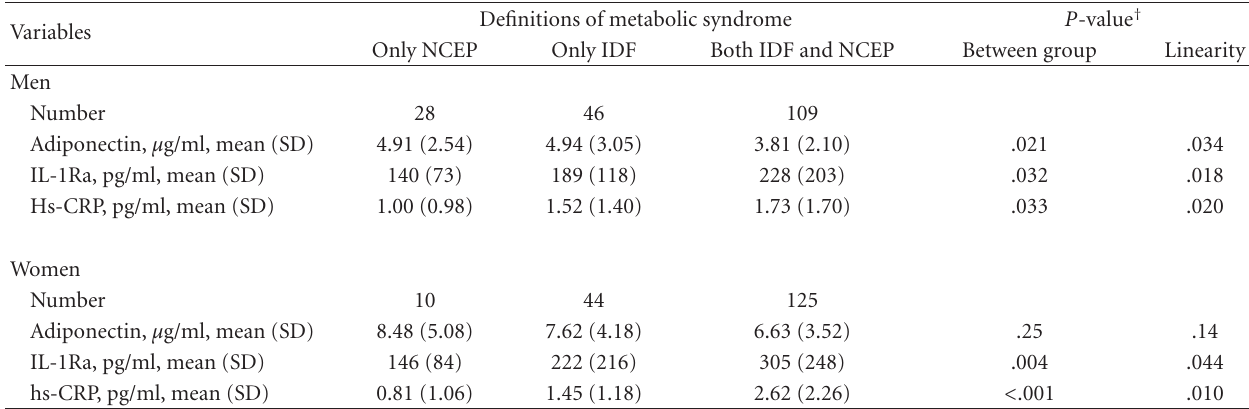
Table 4: Levels of adiponectin, interleukin-1 receptor antagonist (IL-1Ra), and high-sensitivity C-reactive protein (hs-CRP) according to the IDF and the NCEP definitions of the metabolic syndrome, according to